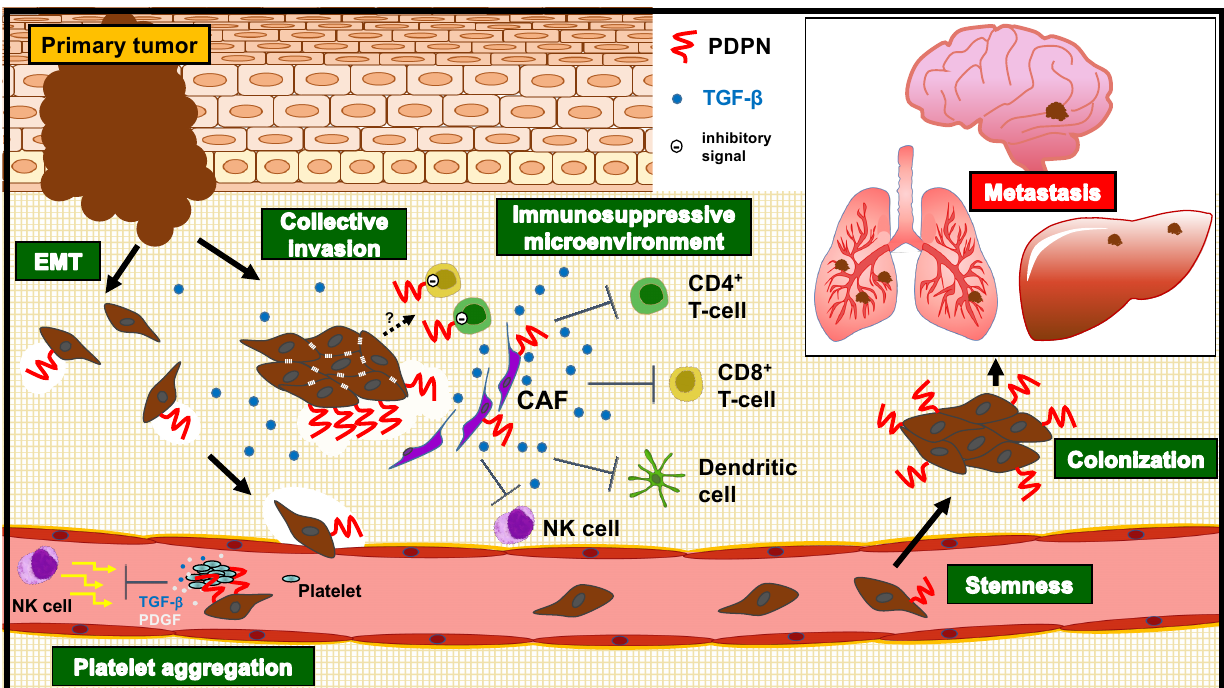
Figure 2. Roles of PDPN in the tumor-metastatic cascade. Tumor metastasis is a multistep biological process termed the invasion-metastasis cascade. PDPN-mediated induction of epithelial to mesenchy- mal transition (EMT) reduces E-cadherin levels and promotes the dissemination of cancer cells from primary sites. PDPN recruits CD44 and MMP14 at filopodia, lamellipodia, and invadopodia and stimulates hyaluronan-binding and extracellular matrix (ECM) degradation, respectively. The intra- cellular actin cytoskeleton reorganization by PDPN also promotes cell motility. These events confer the migration/invasion phenotype and stimulate the intravasation. Note that PDPN expression is observed at the invasive front of the tumor’s collective invasion, which implies the importance of tumor–stroma interaction. PDPN-mediated platelet aggregation promotes survival of shear